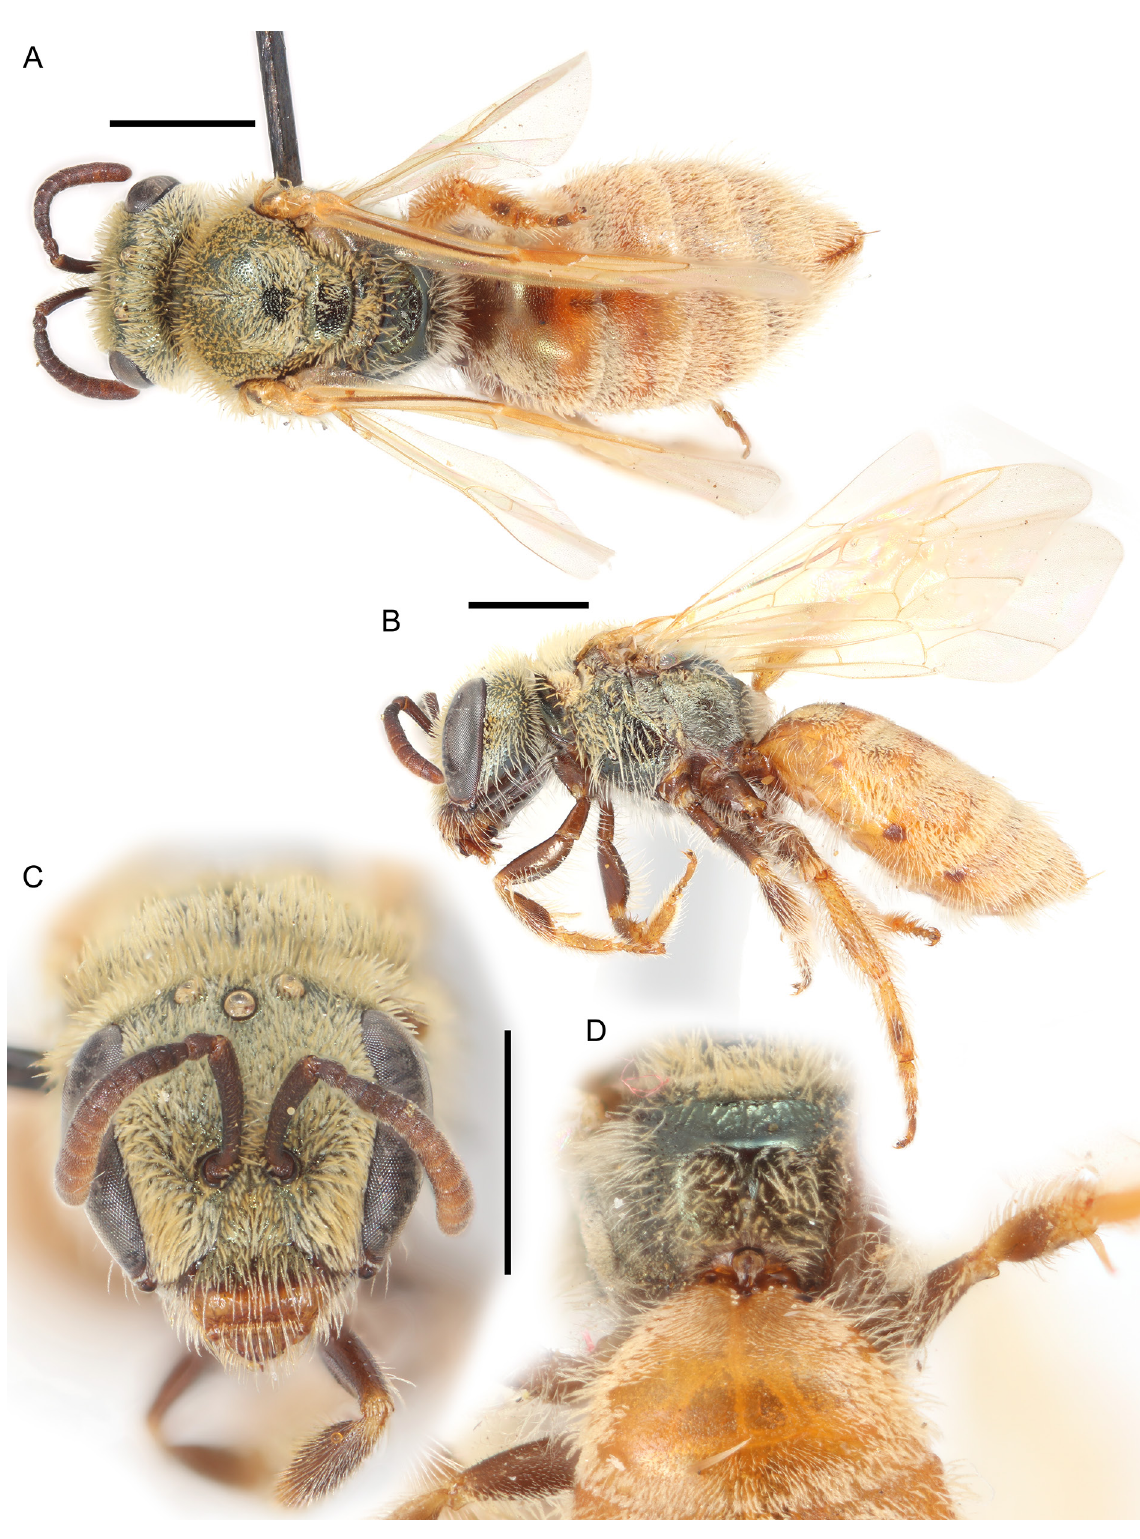
Fig. 19. Lasioglossum ( D. ) cembrilacus sp. nov., ♀. A . Dorsal habitus. B . Lateral habitus. C . Face. D . Propodeum. Scale bars: 1